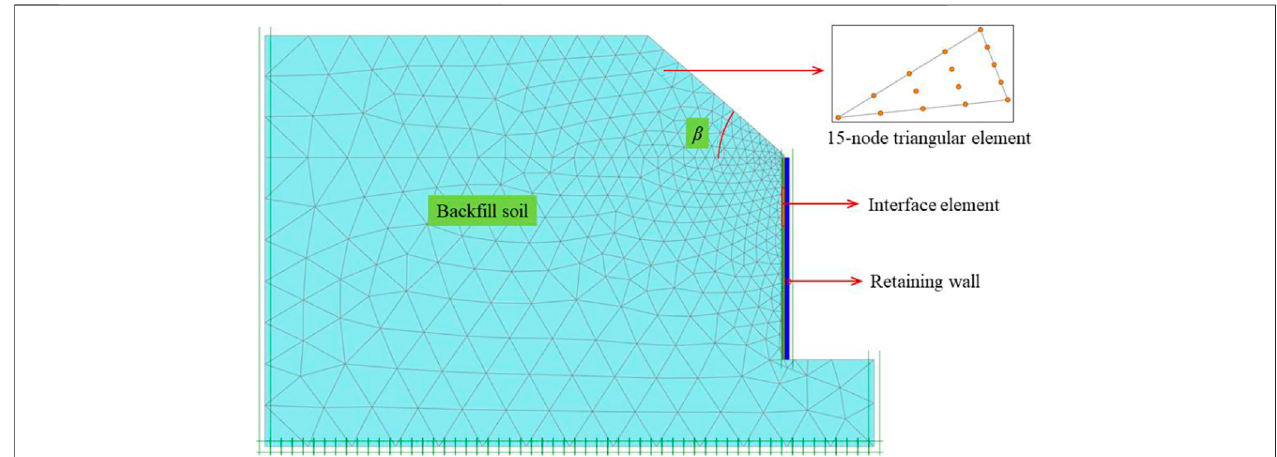
FIGURE 12 | Finite element